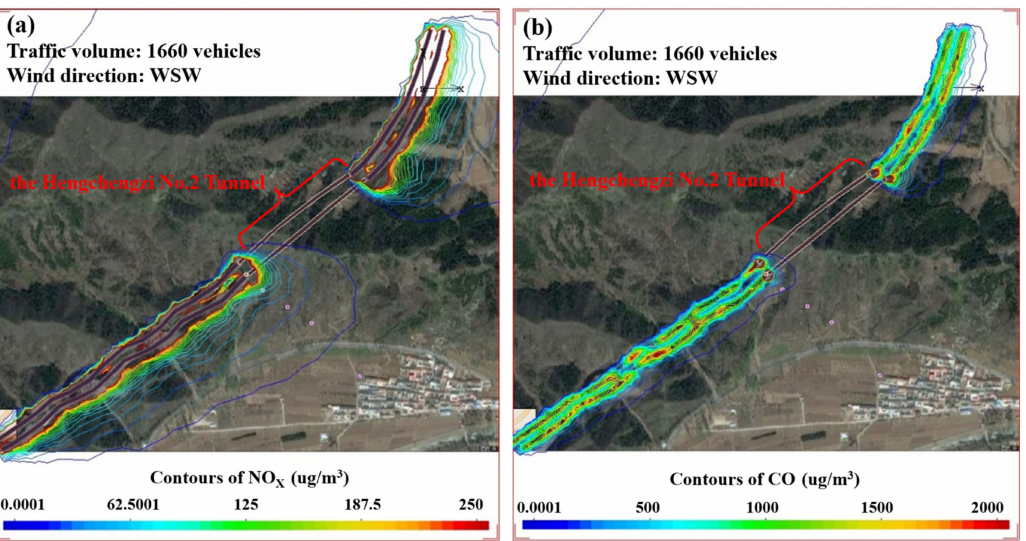
Figure 8. Hourly average concentration distribution of NO X and CO at an off-peak period in the Hengchengzi No. 2 Tunnel section. ( a ) NO X ; ( b )